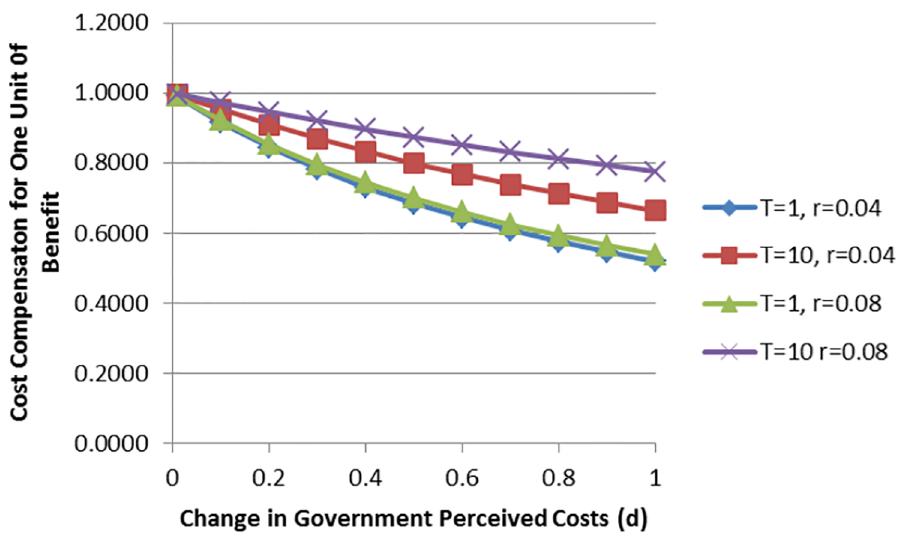
Fig 4. Effect of changes in government perceived costs (d) on cost needed to compensate for one unit of benefit for different discount rates, r, and length in delay, T.